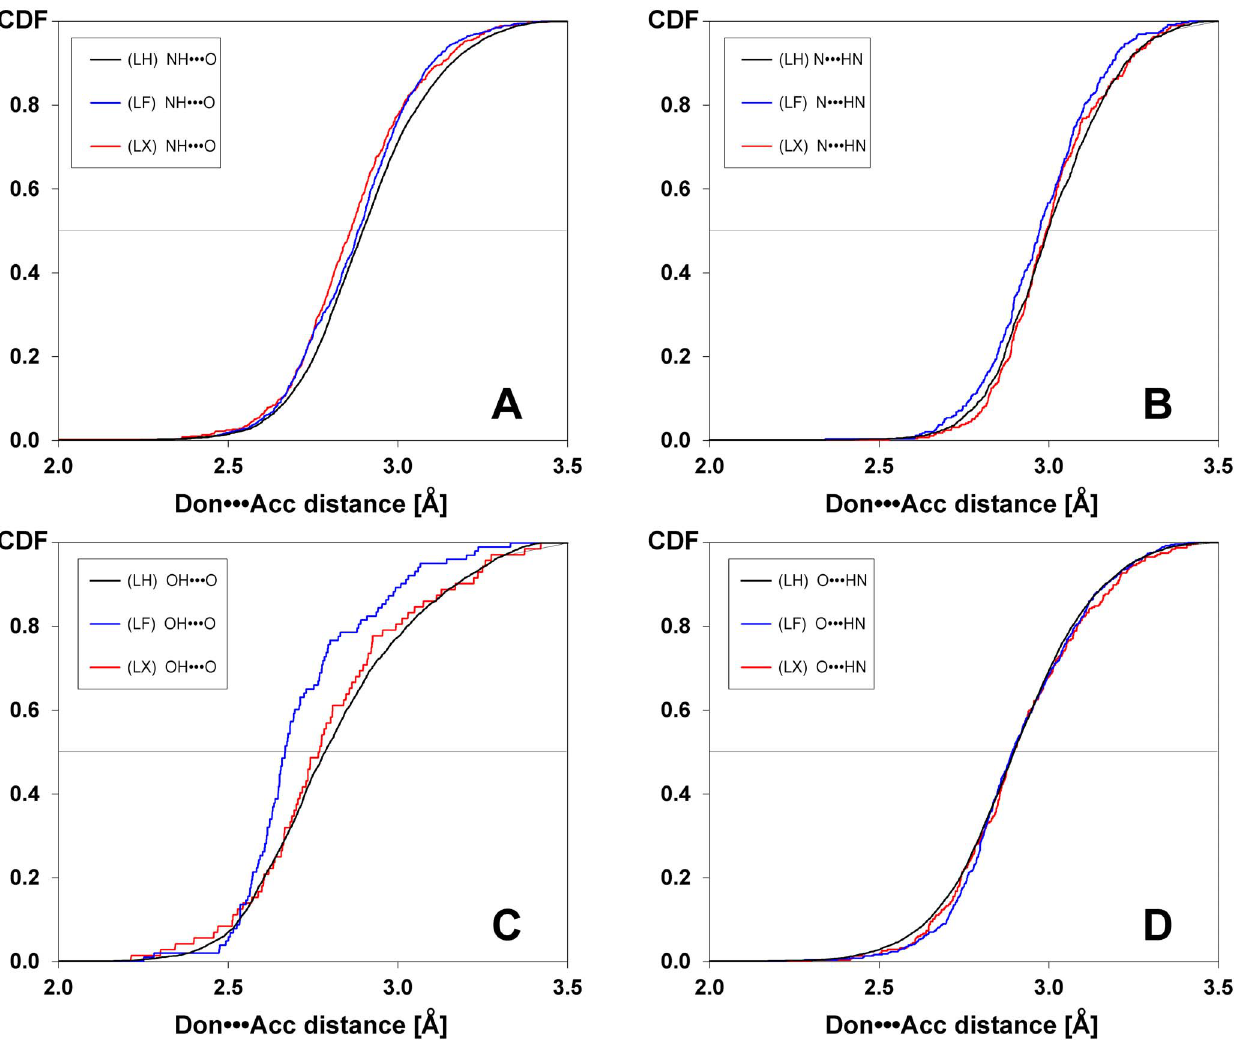
Figure 3. Effect of a halogen atom on cumulative distributions determined for the four most abundant types of hydrogen bond donor-acceptor pairs: NH NNN O (A), OH NNN O (B), N NNN HN (C), and O NNN HN (D), respectively. The distributions estimated for non-halogenated (LH), fluorinated (LF) and other halogenated ligands (LX) are presented in black, blue and green, respectively. See Table 3 for details.